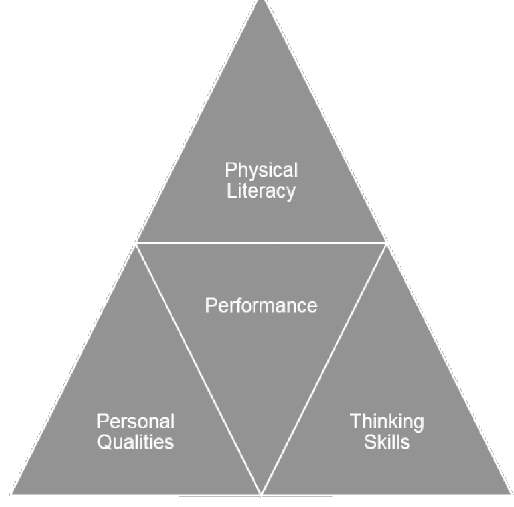
Figure 1. The Learning Framework.